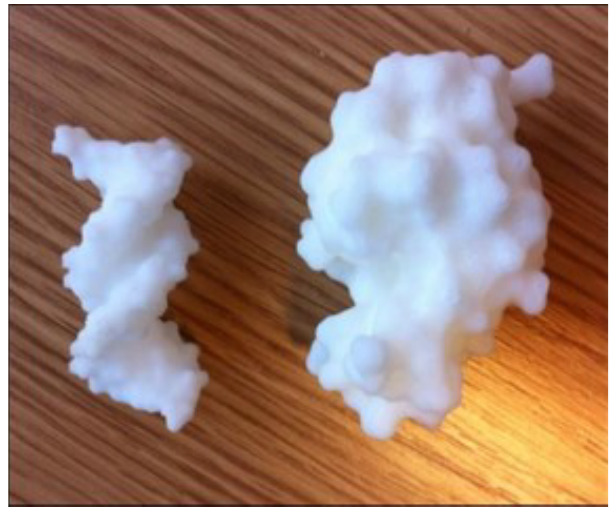
Figure 1. 3D printed models. B-form DNA (left) and the enzyme lysozyme PDB: 2LYZ (right) used within the teaching